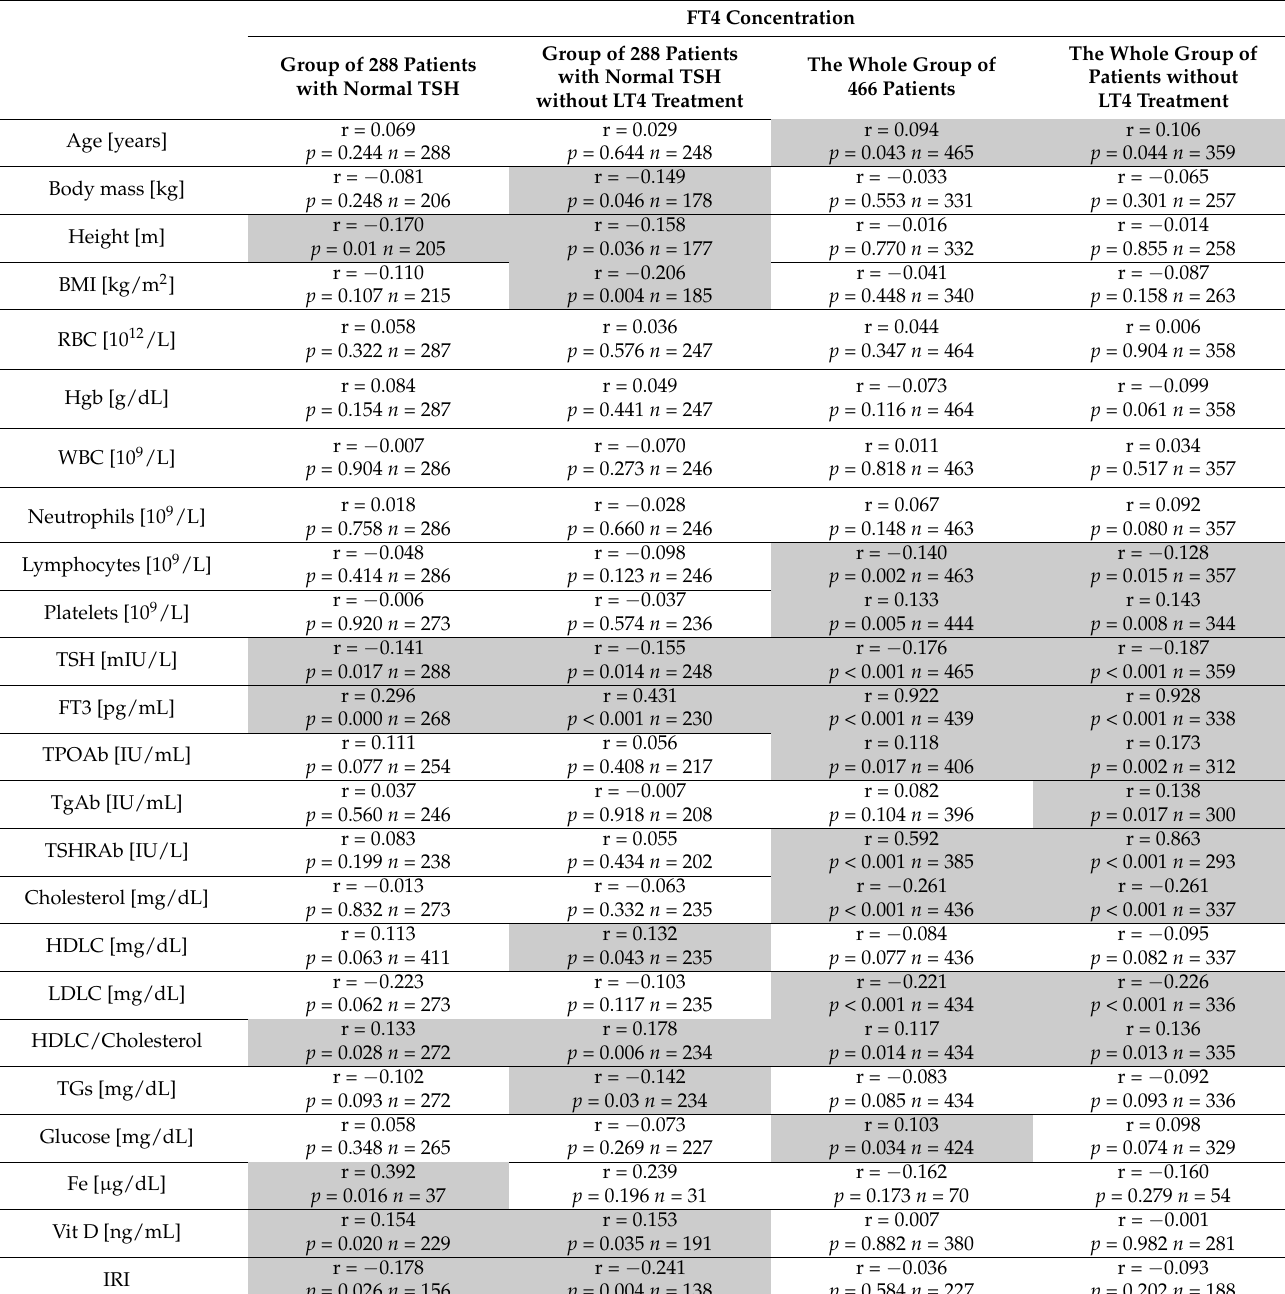
Table 7. Correlations between FT4 concentration and clinical/laboratory parameters in the four groups considered. Statistical evaluation was performed by the Pearson’s correlation test. Statistical significance was determined at the level of p <